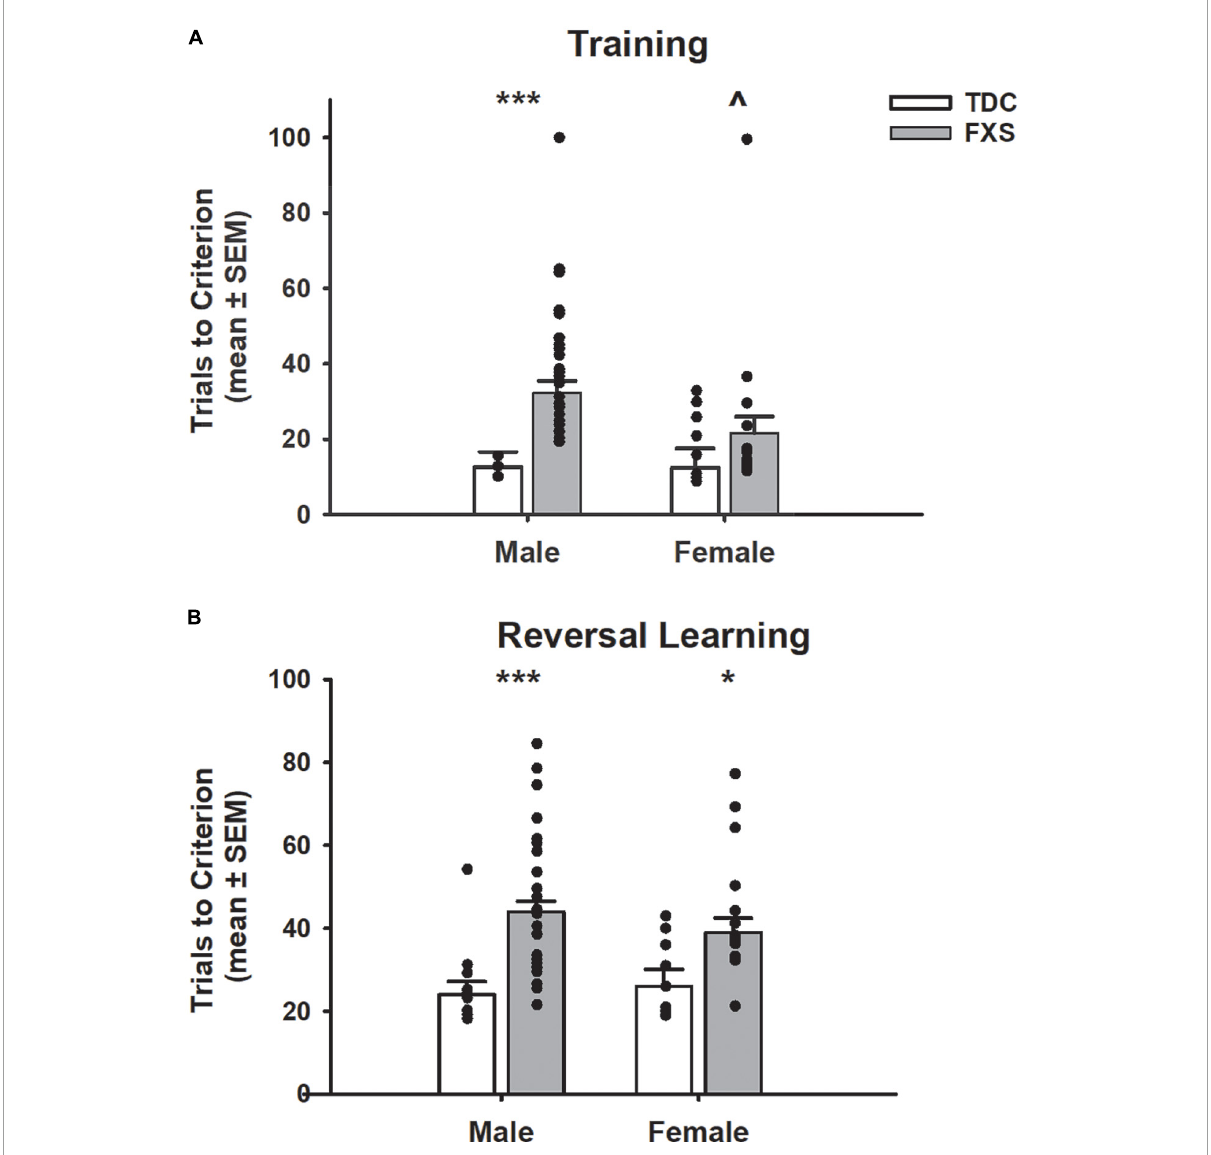
FIGURE3 Trials to reach criterion on a spatial discrimination task (80/20 probabilistic learning procedure). (A) Mean ( ± SEM) trials to criterion on training task (no reversal). Males with fragile X syndrome (FXS), but not females with FXS required significantly more trials to criterion on acquisition than their TDC counterparts. Males with FXS also required more trials than females with FXS. (B) Mean ( ± SEM) trials to criterion on reversal learning. Males and females with FXS required more trials to reach criterion compared to that of control males and females. * p < 0.05 vs. TDC female; *** p < 0.001 vs. TDC male; ∧ p < 0.05 vs. FXS male. Solid dot indicates individual participant data